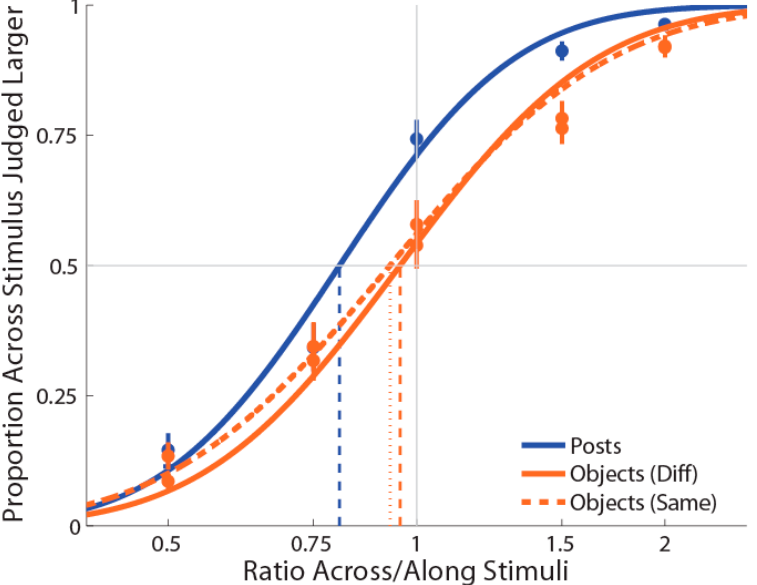
Figure 5. Experiment 3 results in which curves (blue for posts stimulations and orange for objects stimulations, dotted for the same surface) are the cumulative Gaussian functions fit with least-squares regression. Vertical lines represent points of subjective equality (i.e., where the curve crosses 50%). Error bars represent the standard error of the mean (±SEM).